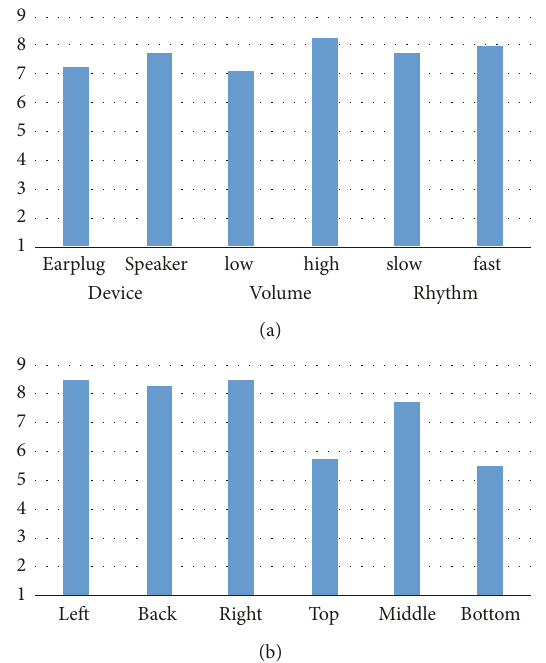
Figure 13: (a) Mean user preference of Device, Volume, and Rhythm. (b) Mean difficulty level of the search task with different horizontal and vertical target